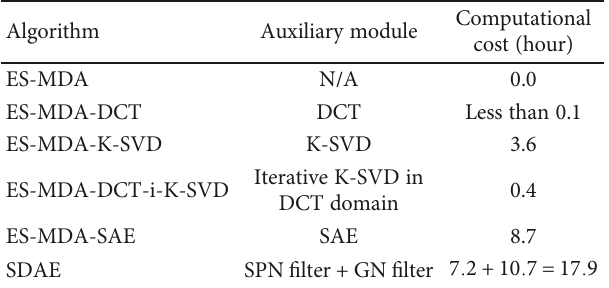
Table 9: Comparison of the computational cost required for executing an auxiliary module embedded in